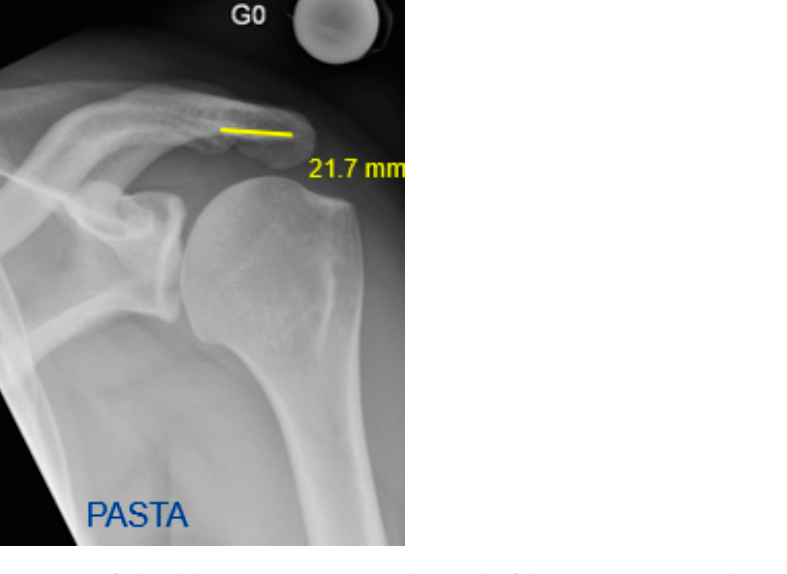
Figure 2. Left shoulder anteroposterior radiograph of the PASTA group indicating a longer sclerotic acromial line (in yellow).